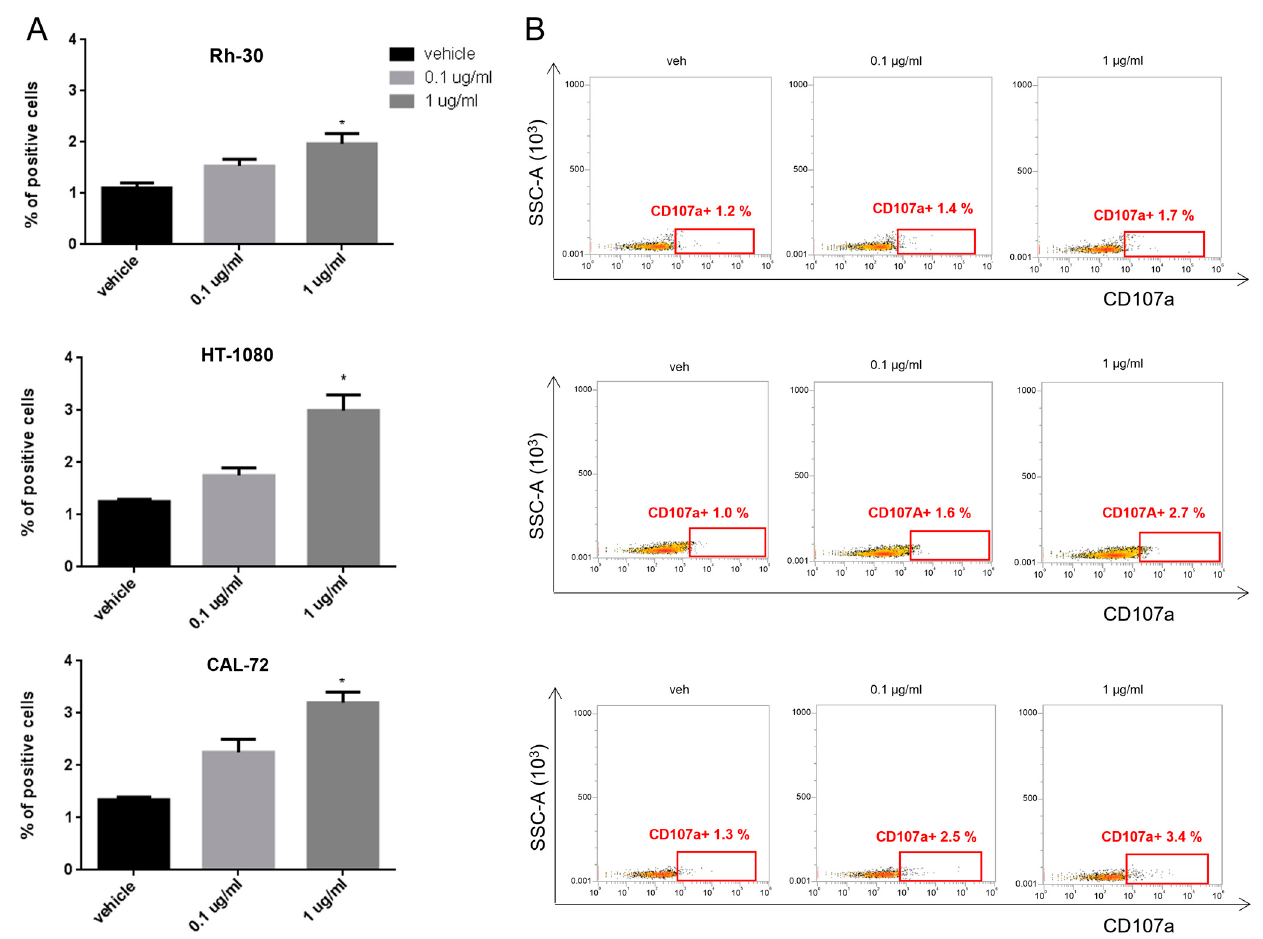
Figure 4. Degranulation assay on activated T lymphocytes. ( A ) Histogram quantification of CD107a- positive T cells from at least 3 donors, co-cultured with Rh-30, HT-1080 and CAL-72 sarcoma cell lines and treated with 0.1 µg/mL and 1 µg/mL of pAXL×CD3 ε for 72 h. ( B ) Representative dot plots of CD107a-positive T lymphocytes analyzed by flow cytometry. Each result is expressed as the mean value of triplicate experiments obtained from each donor. * p < 0.0332.